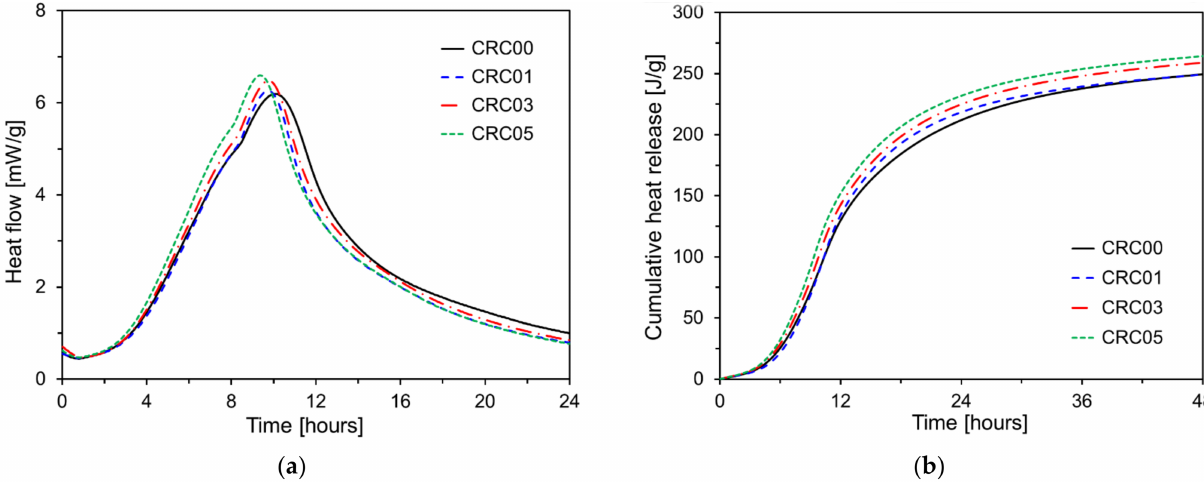
Figure 7. The heat flow and cumulative heat releases of CNT-reinforced cement composites: ( a ) Heat flow; ( b ) Cumulative heat release.